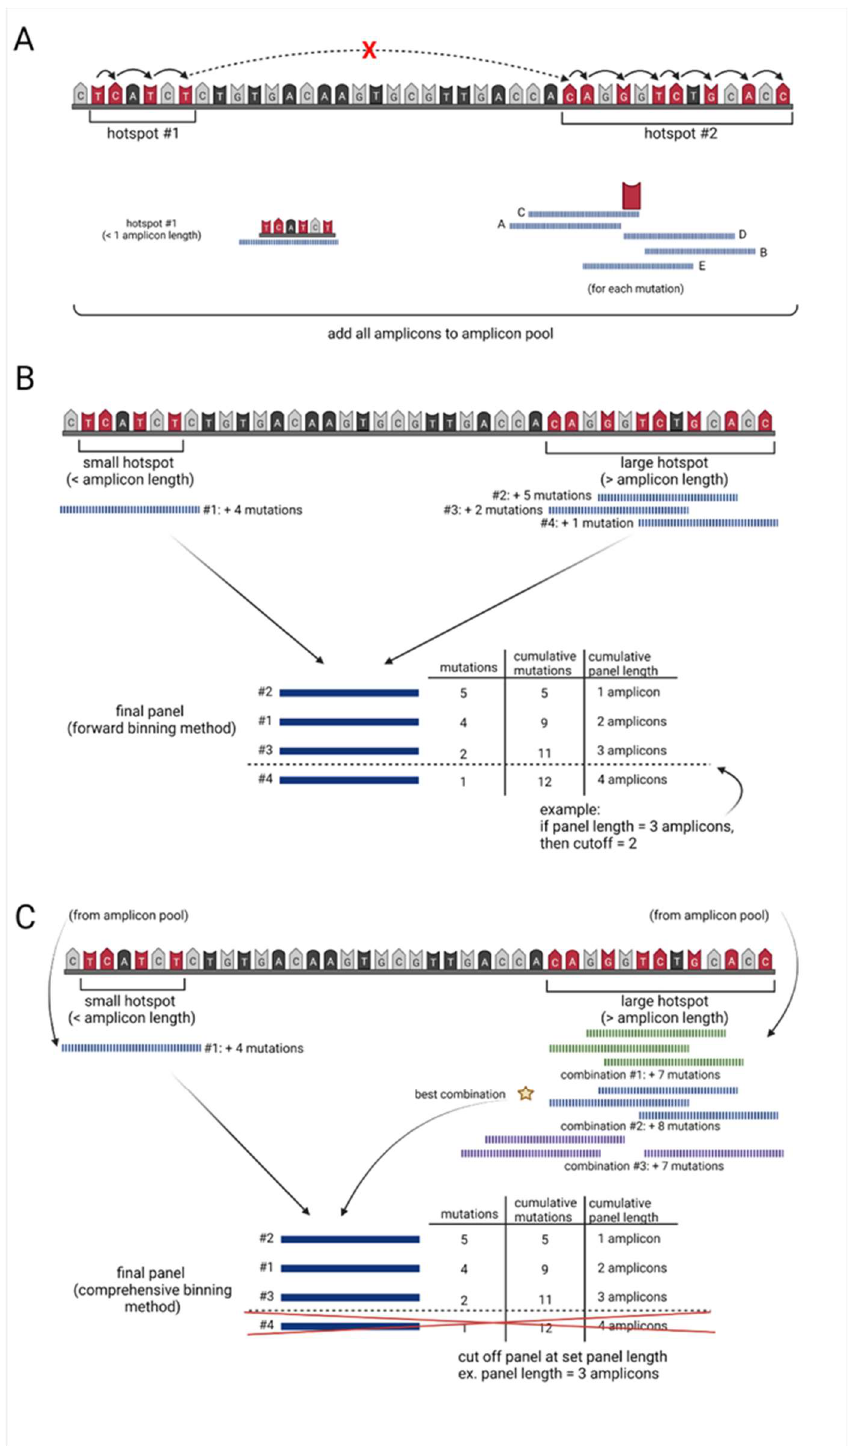
Figure 1. A simplified mechanistic overview of hotspot. ( A ) Amplicon generation, ( B ) forward binning algorithm and ( C ) comprehensive binning algorithm.